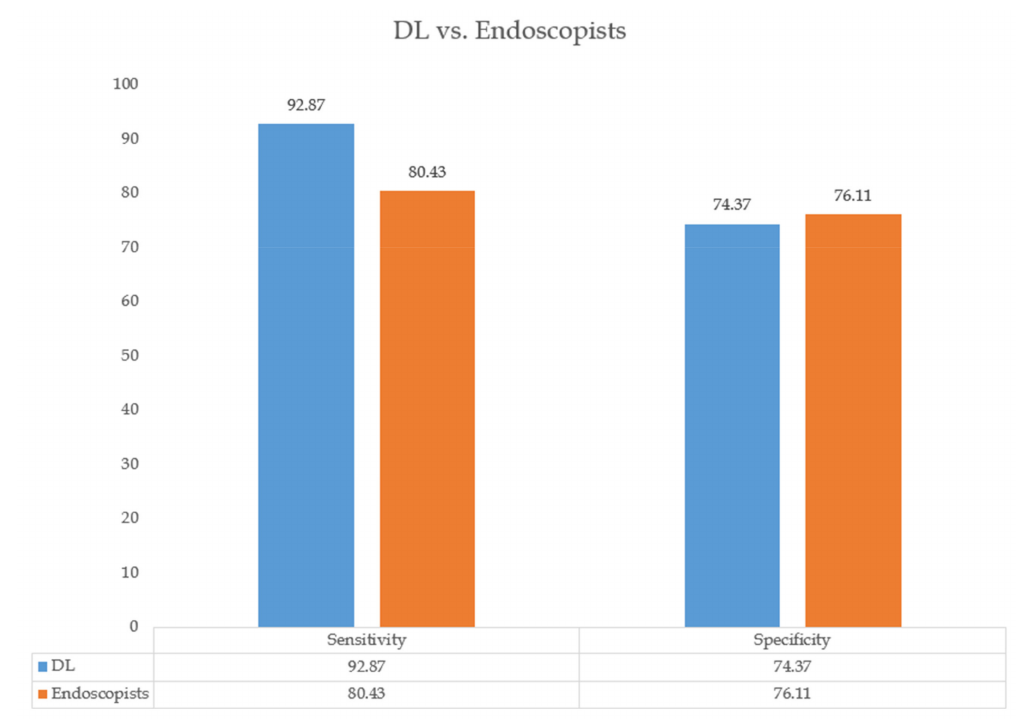
Figure 4. Diagnostic performance for esophageal cancer by the DL system vs. endoscopists.